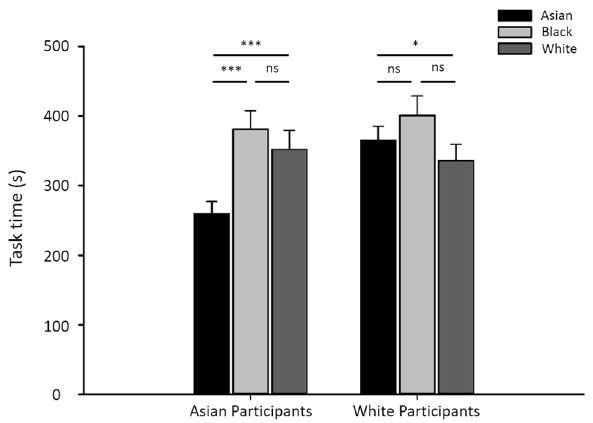
Figure 8. Task time of sorting tasks. There was no evidence that participants spent more time on own-race faces. Error bars show + 1 SEM. *** p < 0.001, ** p < 0.01, * p < 0.05, †,